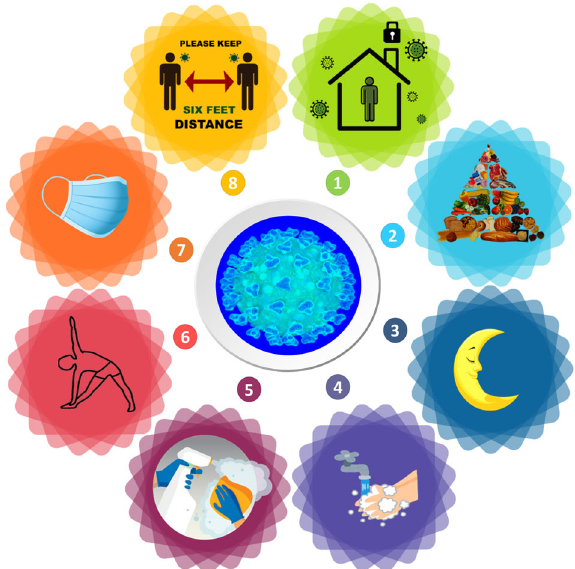
Fig. 2 Main social measures that mitigated COVID-19 spread and helped in disease prevention and control ( fl atten the contagion curve) before vaccine development. (1: quarantine/lockdown/ curfew; 2: healthy and balanced diet; 3: adequate sleeping; 4: frequent hand washing; 5: cleaning and disinfection of both surfaces and the air; 6: regular domestic exercise; 7: facemask wearing; and 8: social